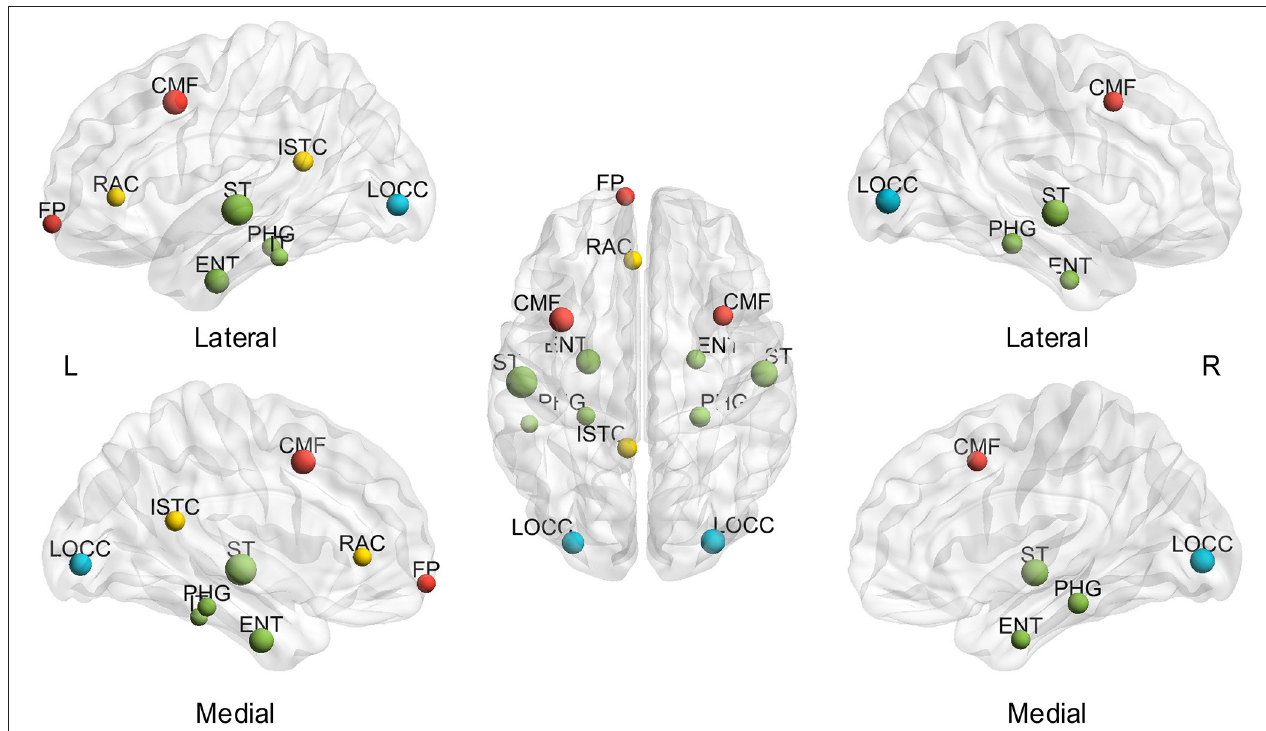
FIGURE 4 | Hubs in over 20% of subjects based on the average of sparsities. L, left; R, right; A, anterior; P, posterior; CMF, caudal middle frontal gyrus; ENT, entorhinal cortex; FP, frontal pole; ISTC, isthmus cingulate; IT, inferior temporal gyrus; LOCC, lateral occipital gyrus; RAC, rostral anterior cingulate; PHG, parahippocampal; ST, superior temporal gyrus. The size of the node represents the proportion of subjects; the largest node denotes 54.55% of the proportion. The different color of nodes denotes the different lobes: red-frontal lobe; green-temporal lobe; blue-occipital lobe; yellow-cingulate.